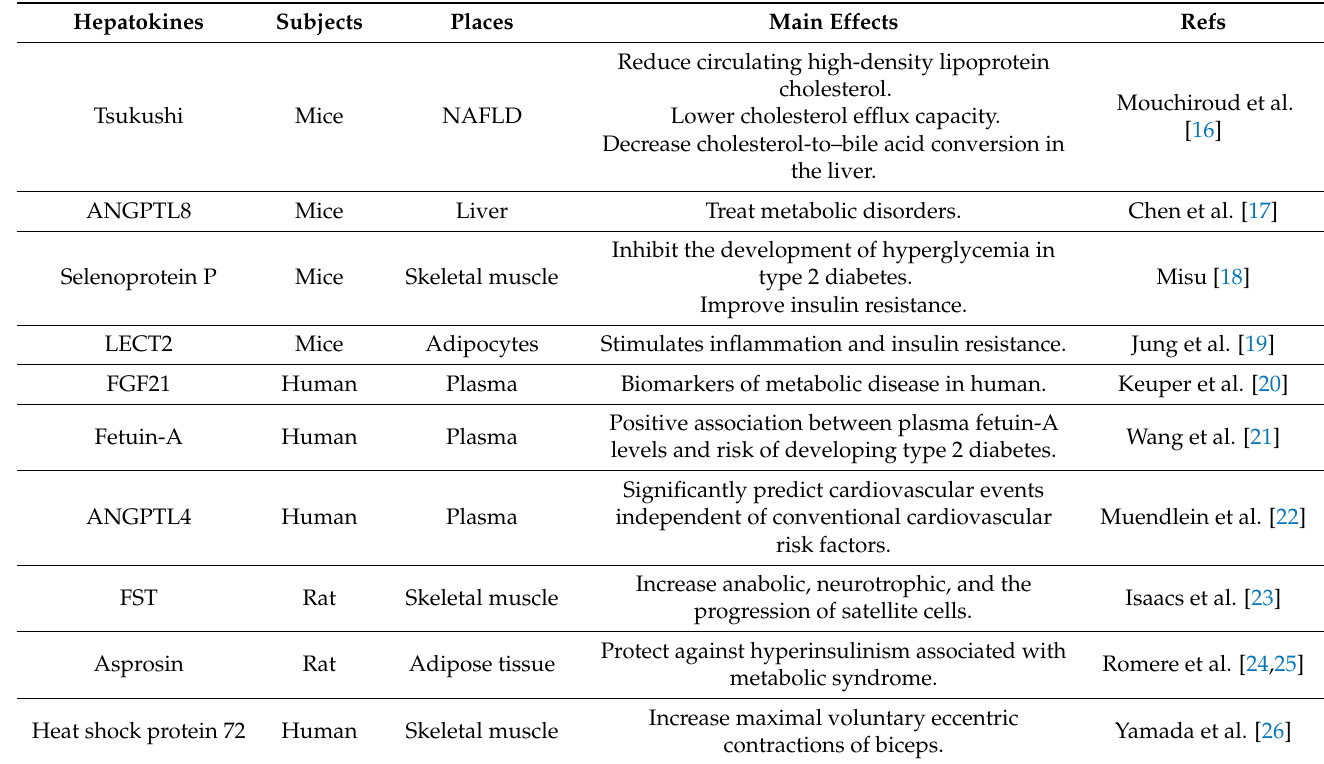
Table 1. The role of hepatokines in tissues and the